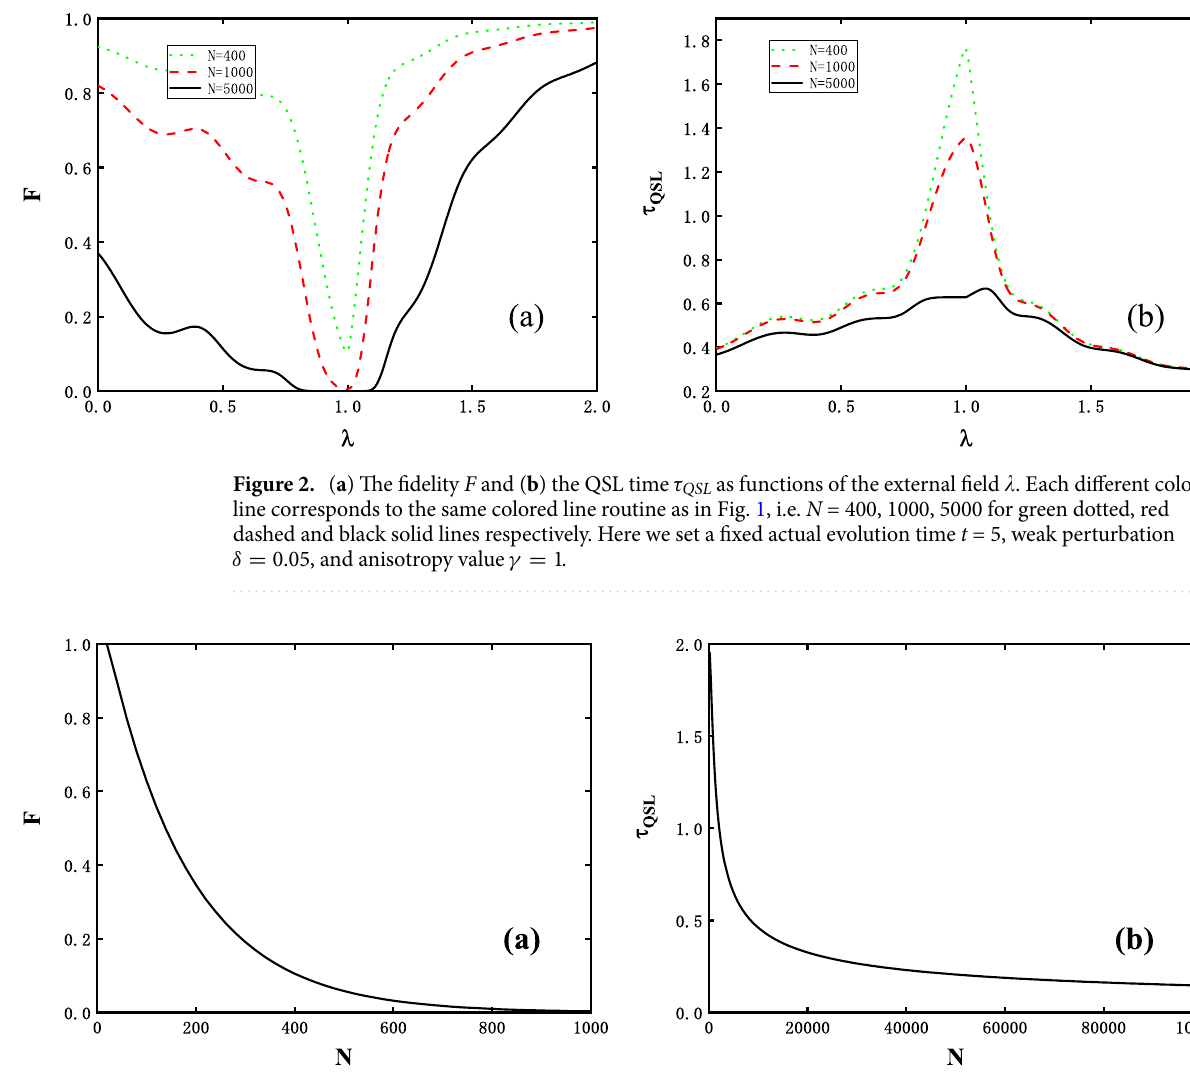
Figure 3. Selected fixed time instants at t = 5 during the dynamical evolution of the quenched spin chain at 1 for illustrating ( a ) the fidelity F and ( b ) the QSL time 1 and critical external field (cid:31) anisotropy value γ = = τ QSL as functions of N